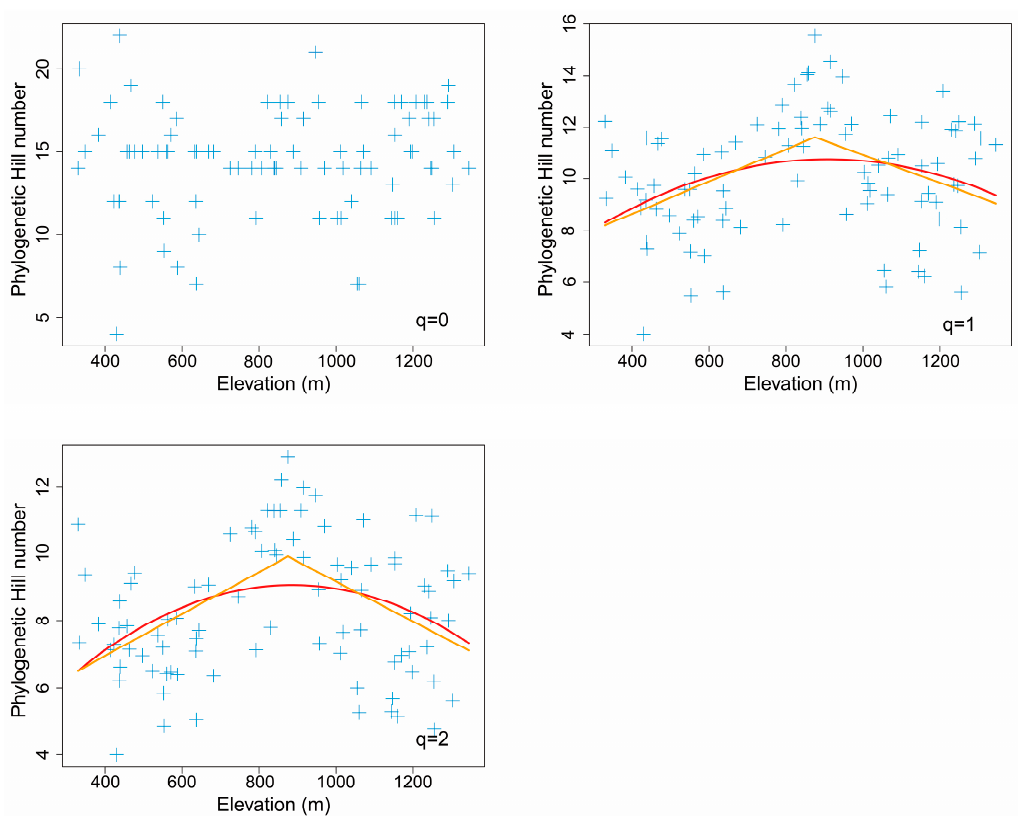
Figure 5. The elevational pattern of phylogenetic Hill numbers for leaf mines on Quercus variabilis Blume. The orange line was fitted with the piecewise linear model, while the red line was fitted with the nonlinear quadratic model.